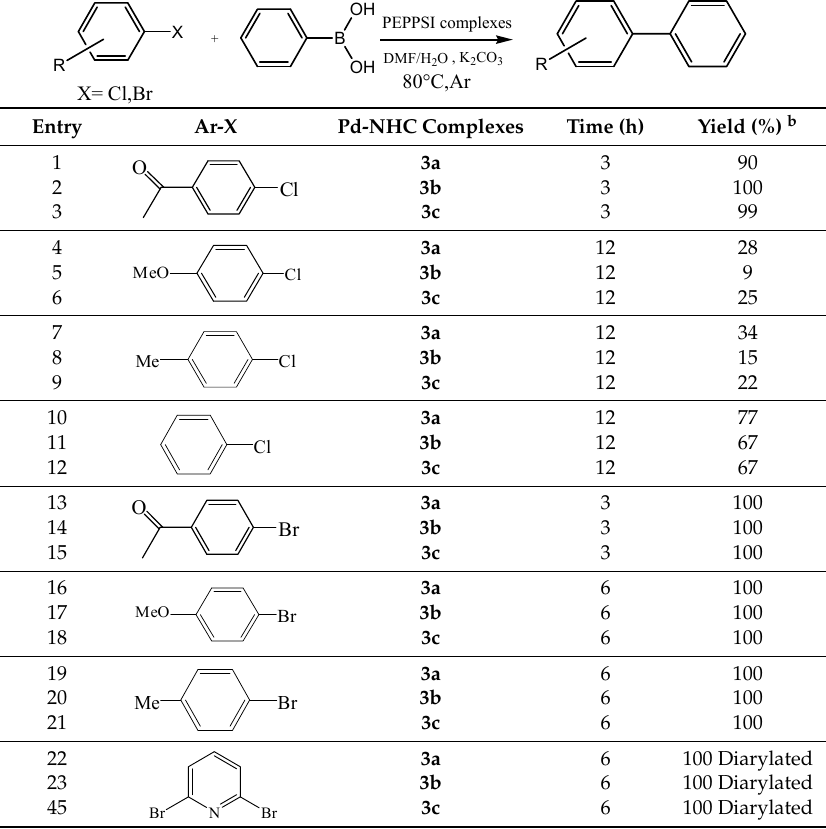
Entry Ar-X Pd-NHC Complexes O Cl